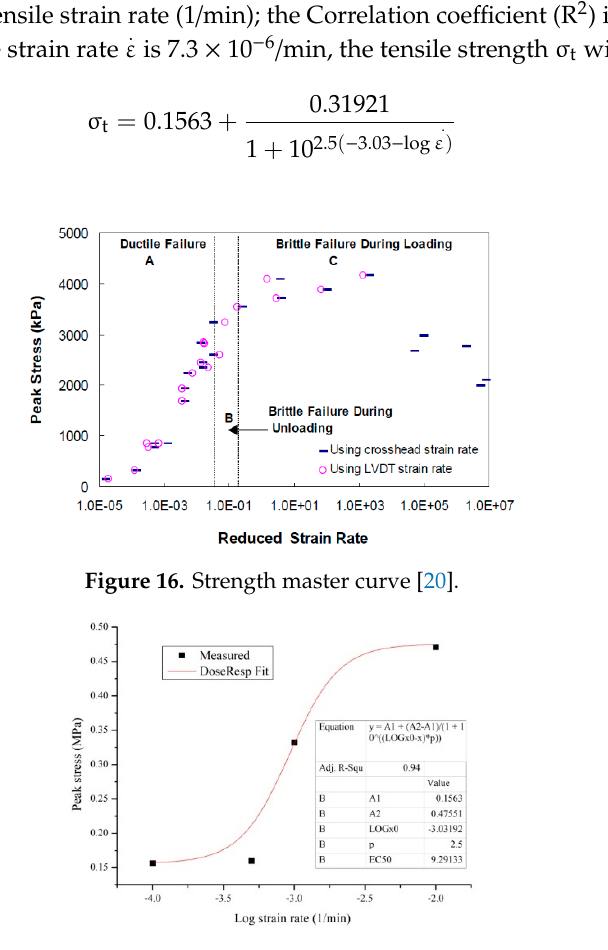
Figure 17. Fitting curve of strength and strain rate.